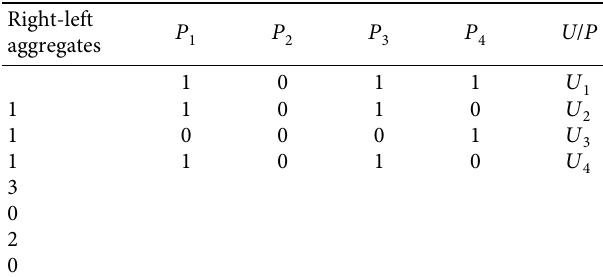
Table 5: Right-left diagonal aggregate